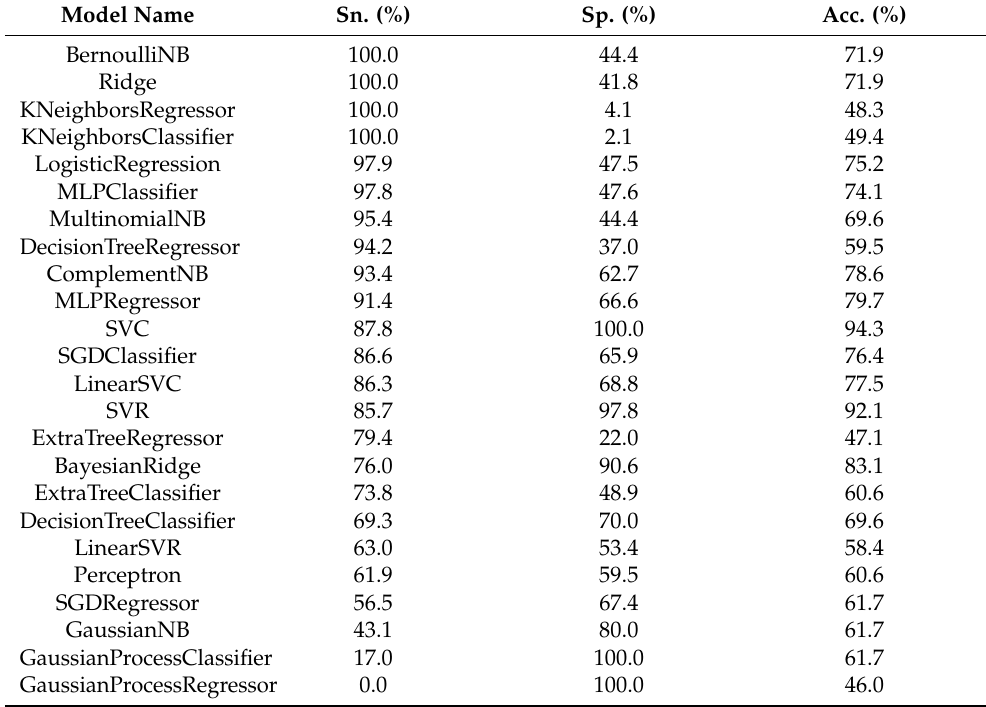
Table A1. Model output (loss function with ratio of 1:3, ratio of training and testing examples 50%:50% for the MH dataset, sorted descending by sensitivity.